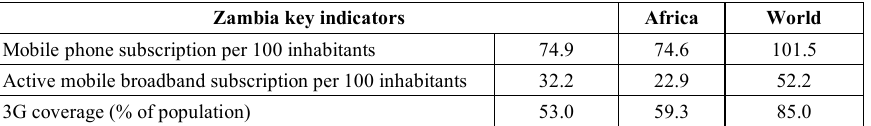
Table 2. GSM and Internet